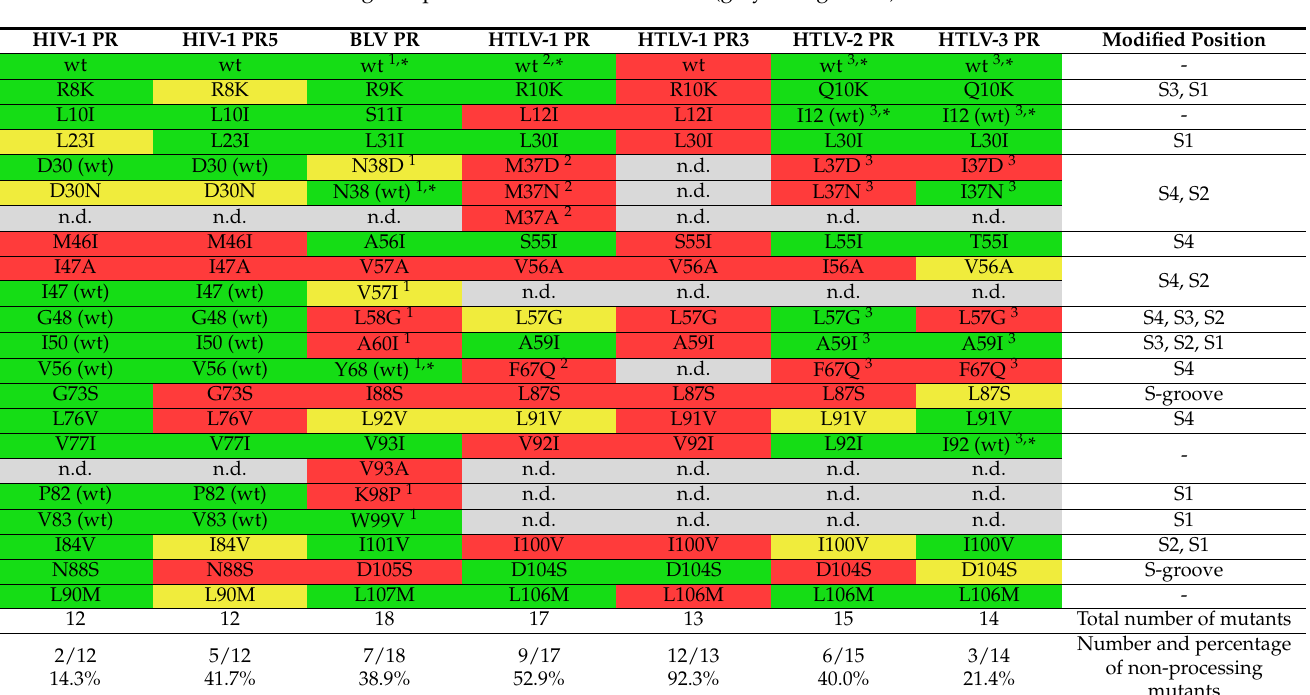
Table 2. Capabilities of the MBP-fused proteases for autoproteolysis. The effects of single point mutations are shown based on the results of Western blot experiments (Figure 3). The herein studied set of mutants was completed with those that were studied previously: 1 [33], 2 [34], and 3 [35]. Asterisk indicates that a previously studied mutation was investigated in this work as well. Complete and partial self-processing is indicated by green and yellow colors, respectively, while red background indicates that the mutation blocked autoproteolysis. n.d.: the effect of the corresponding mutation in the given position was not determined (grey